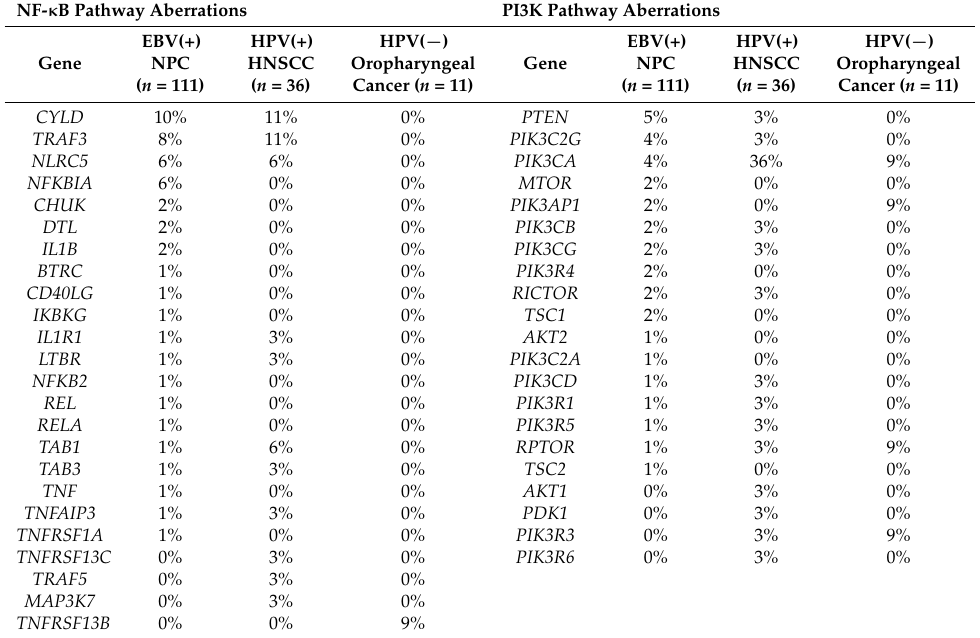
Table 3. Tables showing the percentage of tumor with somatic mutations in the most affected NF- κ B pathway and PI3K pathway in EBV(+) NPC, HPV(+) HNSCC and HPV( − ) oropharyngeal cancer,